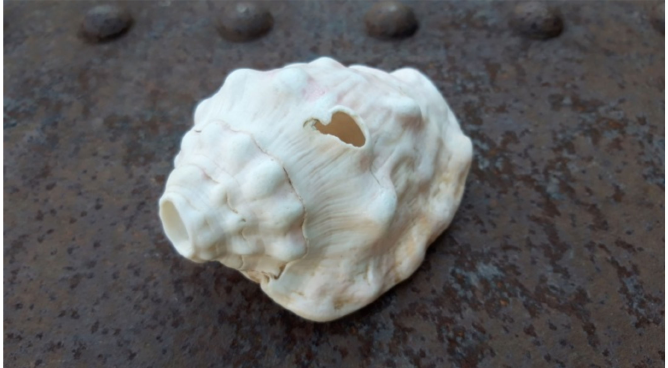
Figure 11. Shell horn made from Aliger gigas . Experimental model by the author (2021), length: 9.5 cm. For experimental playing, the irregular damage on the body whorl had been sealed.